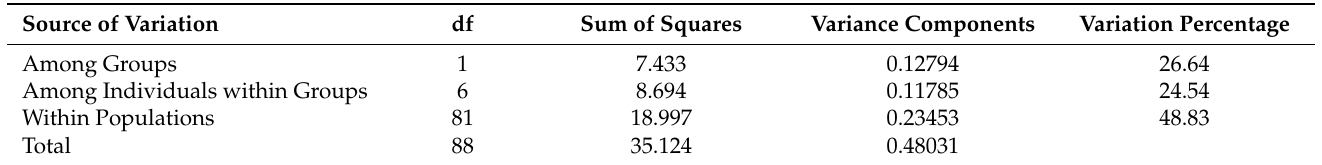
Table 4. Analysis of molecular variance (AMOVA) of ND4 mitochondrial gene of Aedes aegypti from,